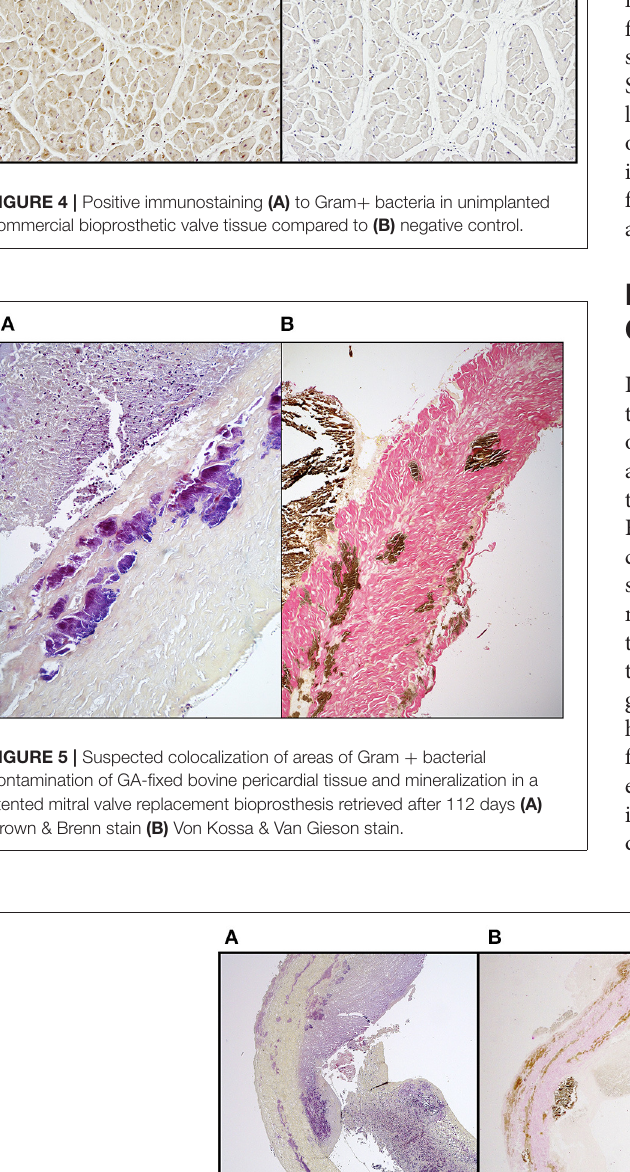
Frontiers in Cardiovascular Medicine |